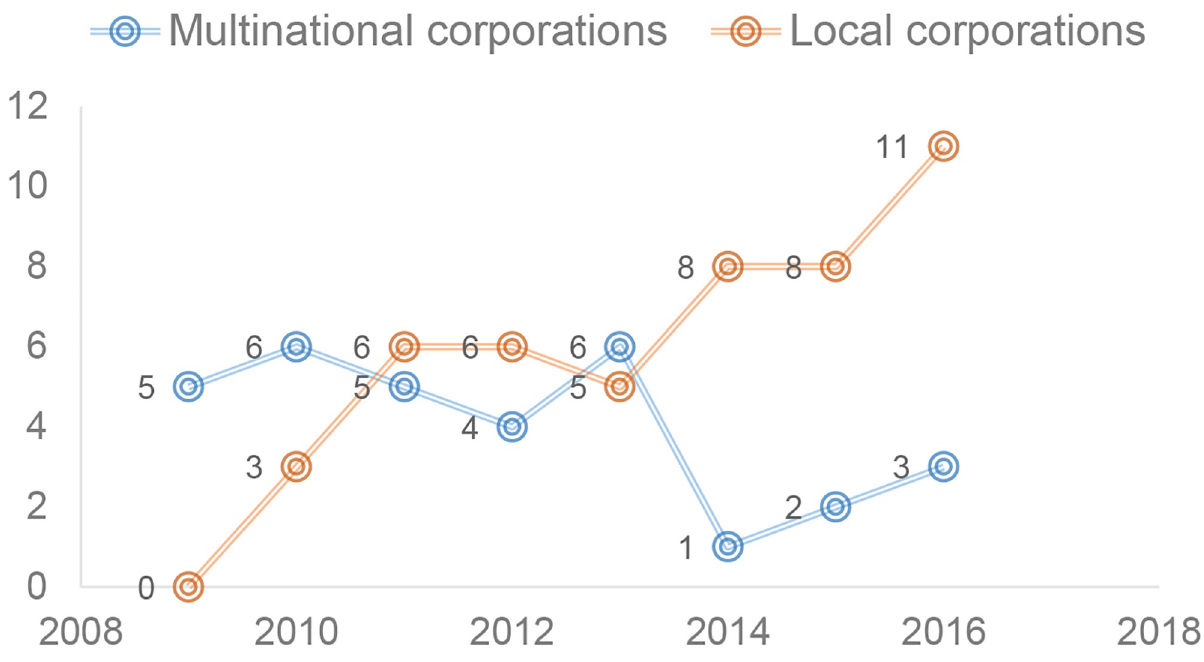
Fig 1. The number of corporations selected in the “China Greenwashing List” from